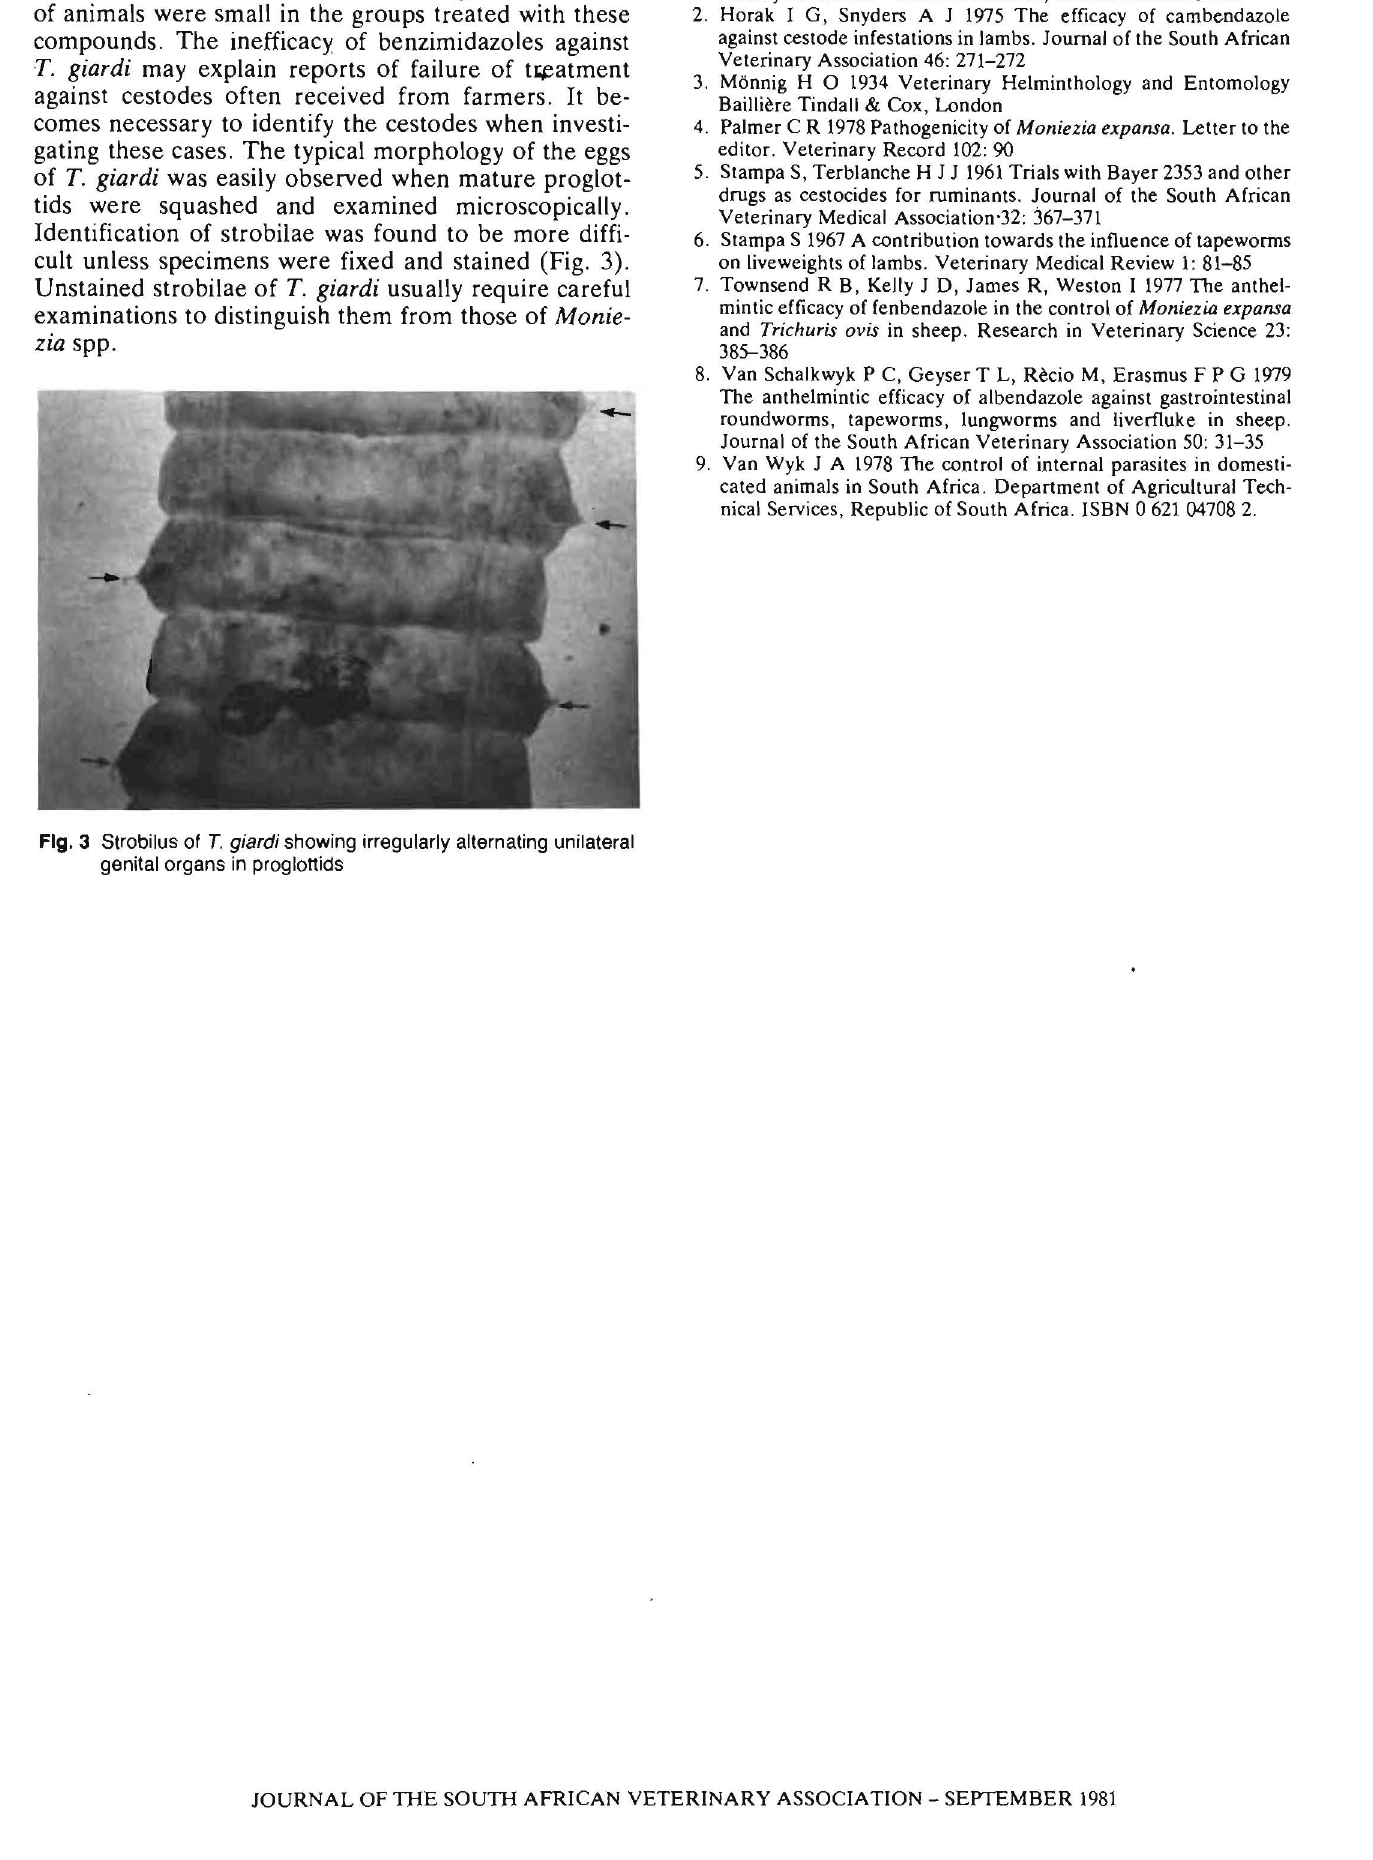
Fig. 3 Strobilus of T. giardi showing irregularly alternating unilateral genital organs in